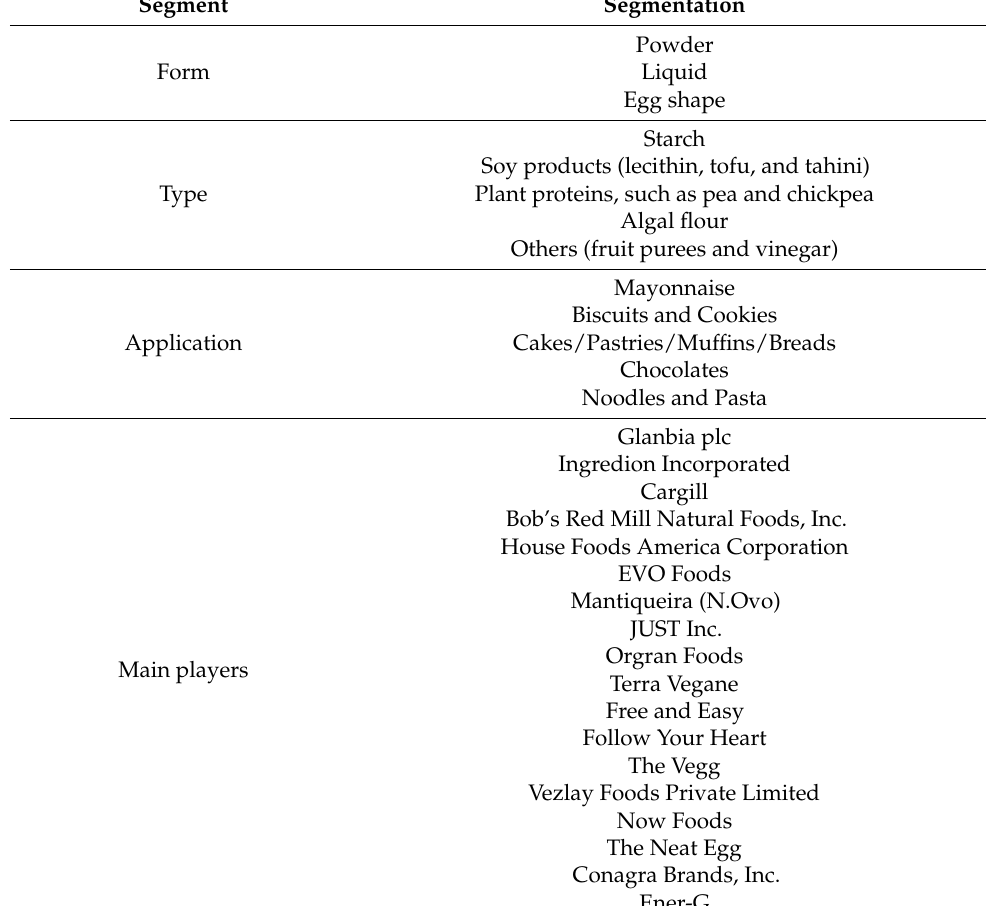
Table 2. Segmentation of the global market of vegan eggs adapted from